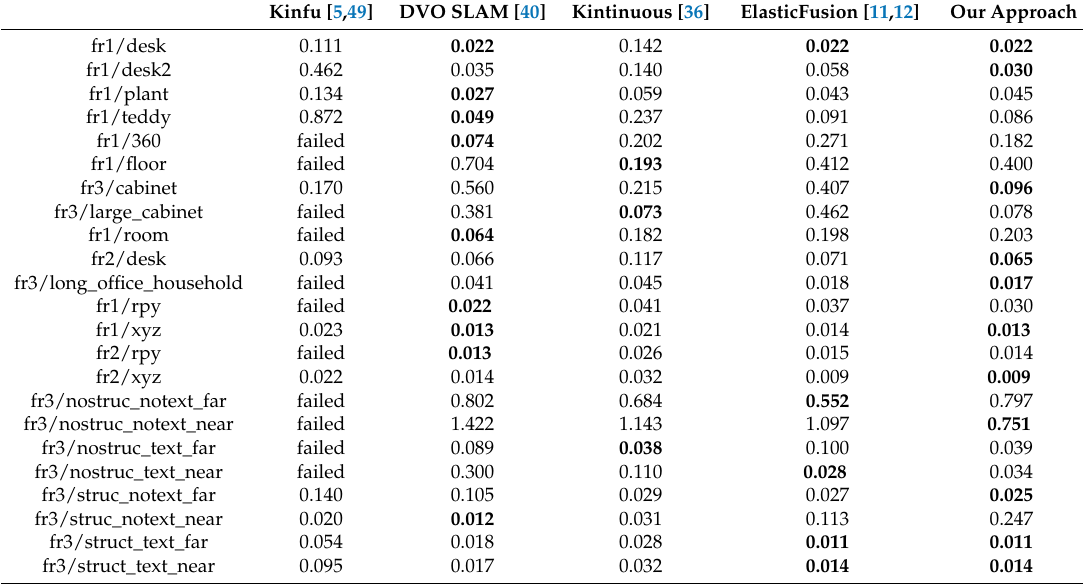
Table 2. Comparison of camera tracking accuracy results on the TUM RGB-D benchmark (ATE RMSE in